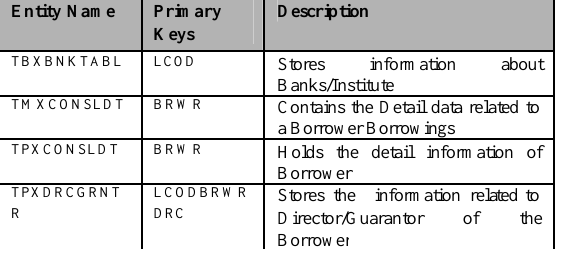
Table 2: Operational Entity Summary